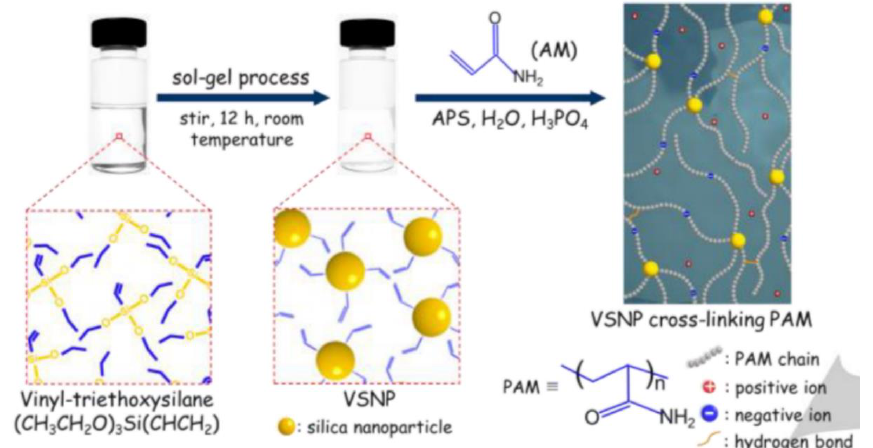
Figure 3. Preparation of vinyl hybrid silica nanoparticles (VSNPs) from vinyl-triethoxysilane nanoparticles followed by the synthesis of VSNP-PAM from VSNPs (crosslinking agent), ammonium persulfate (APS, initiator), acrylamide (AM, main monomer), and phosphoric acid (proton source) [11] .